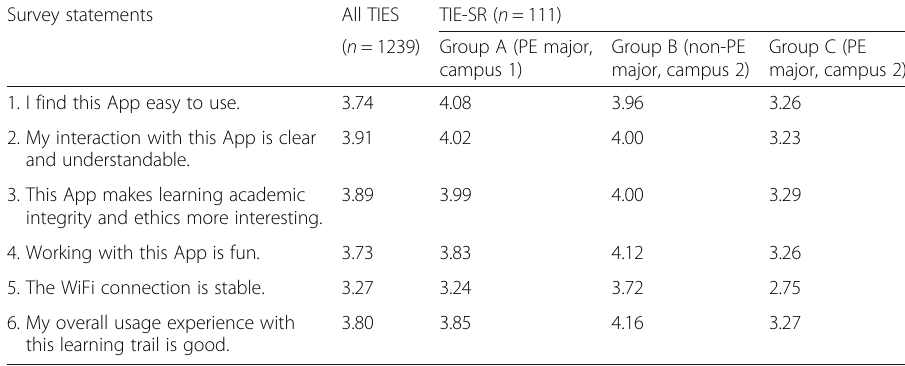
Table 4 Consolidated Likert-scale responses to user surveys Survey